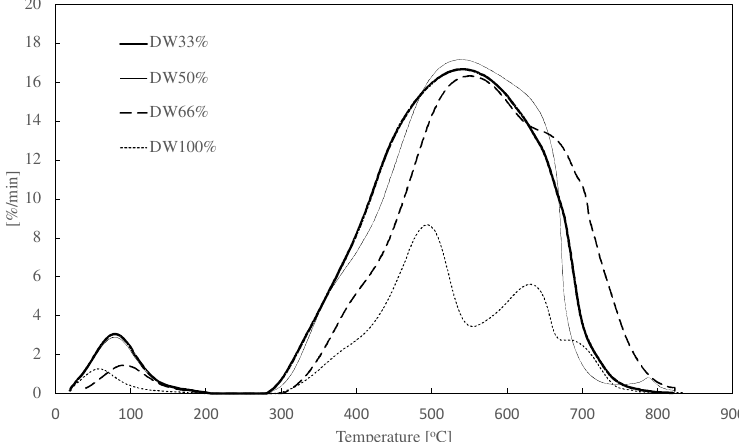
Figure 5. DTG curves of char from carbonization different pellets composition. Table 5. Combustion characteristic parameters of the distillery waste